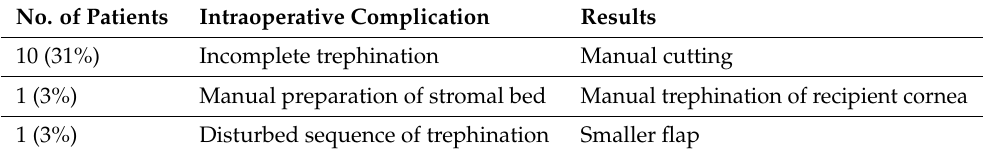
Table 3. Intraoperative complications.